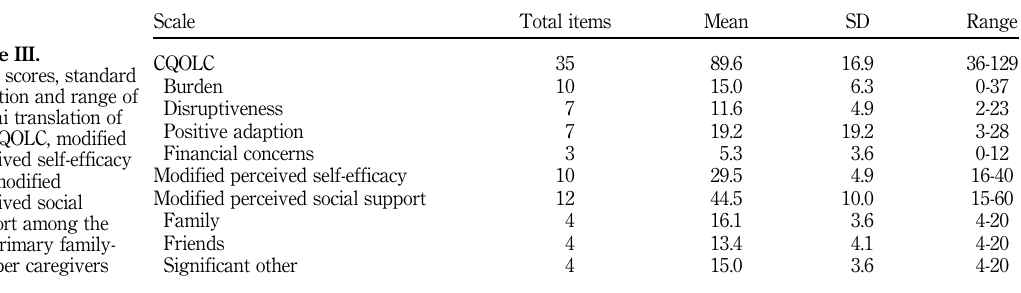
Table II. General characteristics of the 178 primary family-member caregivers